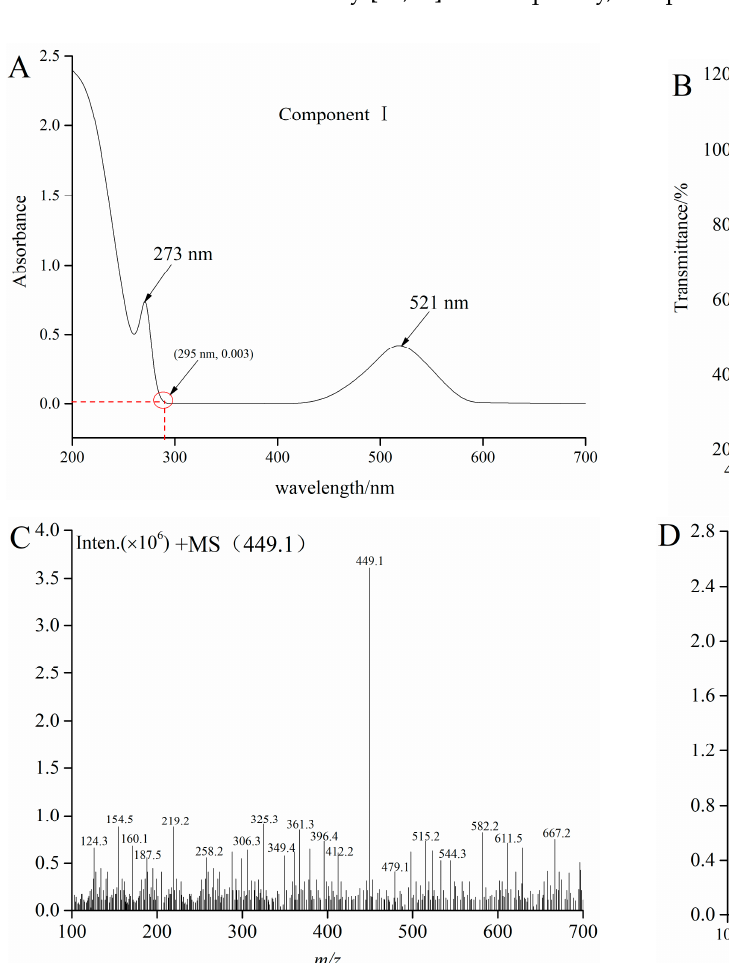
Table 1. Identify of the component I using HPLC-ESI-MS/MS.